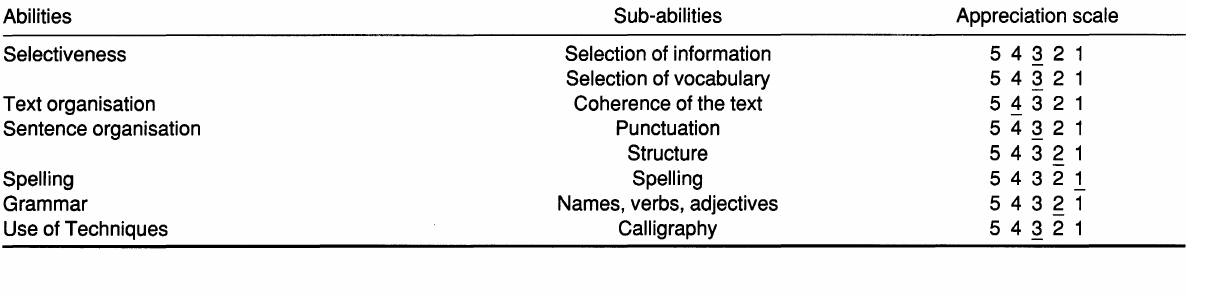
TABLE II. Melodie's results on the special educator's writing skills test